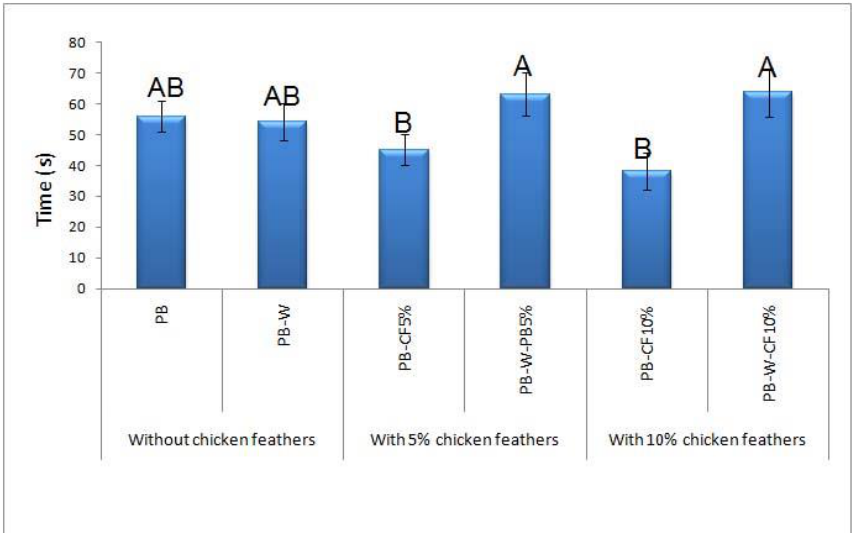
Figure 1. Time to the onset of ignition (in seconds) in six particleboard panels made from wood chips and the two chicken feather contents of 5% and 10%, containing 10% wollastonite (PB = particleboard panels; W = panels containing wollastonite; CF = chicken feather content) (letters on each column bar represent groupings based on Duncan’s multiple range test, α = 0.05).